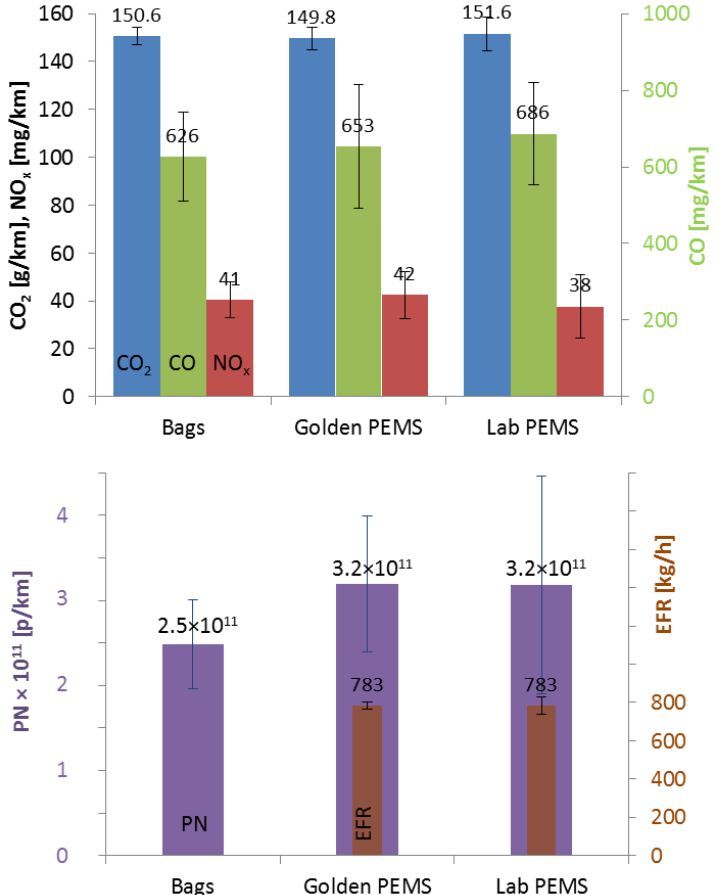
Figure 1. Mean emissions from all laboratories with different equipment: Bags (eight laboratories), Golden Portable Emissions Measurement Systems (PEMS) (seven laboratories, one instrument), Lab PEMS (five laboratories, five instruments). Upper panel shows gaseous pollutants. The lower panel shows particle number and mean exhaust flow rate (EFR). Error bars show one standard deviation.